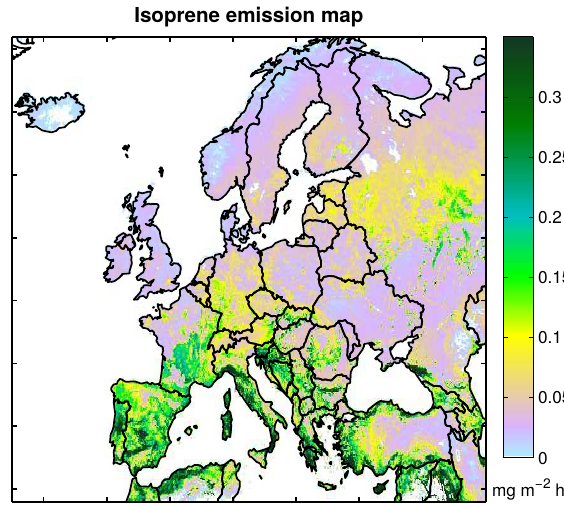
Figure 2. Isoprene emission map from the H3 simulation (Table 1), showing the distribution of isoprene emissions (in mgm − 2 h − 1 ) us- ing the ERA-Interim reanalyses for